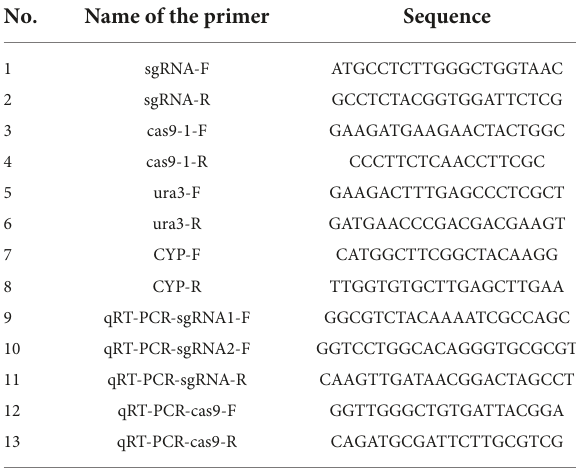
TABLE 1 The primers for PCR and qRT-PCR analysis.